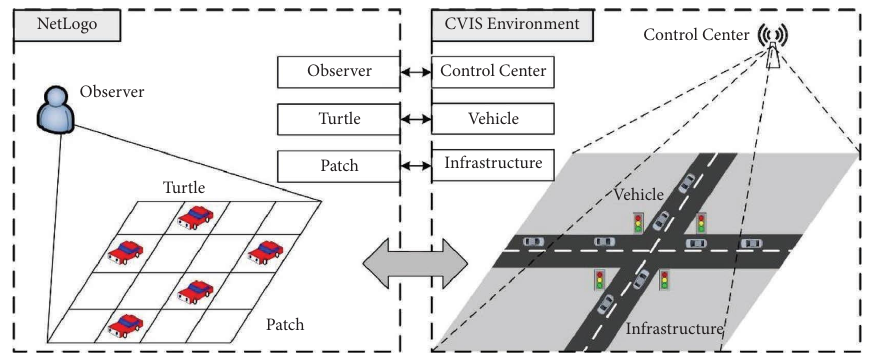
Figure 6: Mapping between NetLogo world and CAV environment.